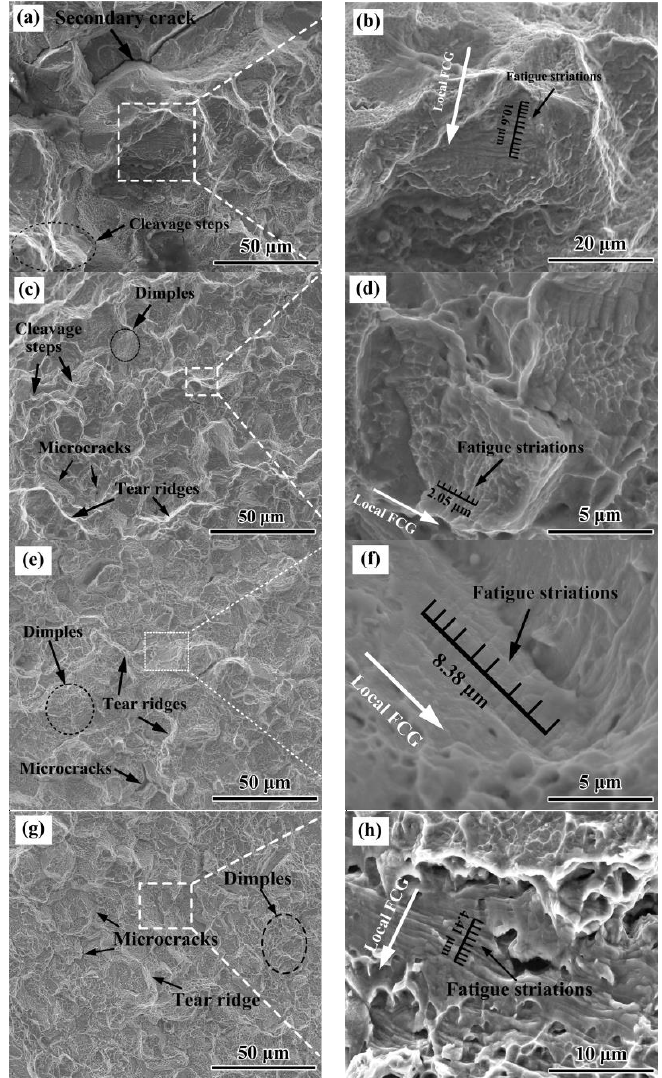
Figure 11. SEM images of the fracture surface of the samples tested at total strain amplitude of: 1.2% ( a – d ); and 1.8% ( e – h ), showing the morphology in the FCG zone for: the NA alloy ( a , b , e , f ); and the DA alloy ( c , d , g , h